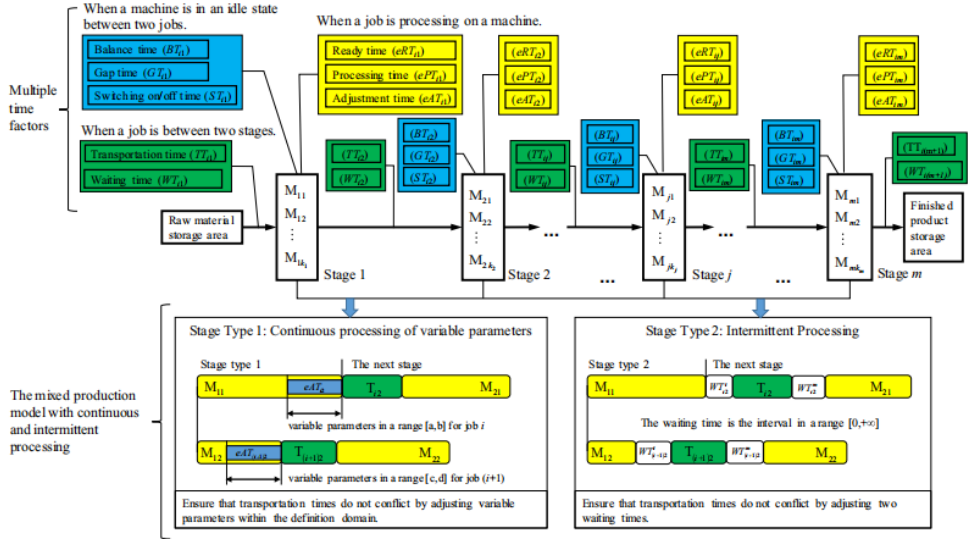
Figure 3. Mixed flow shop scheduling model and mixed production model considering multiple time factors [11].